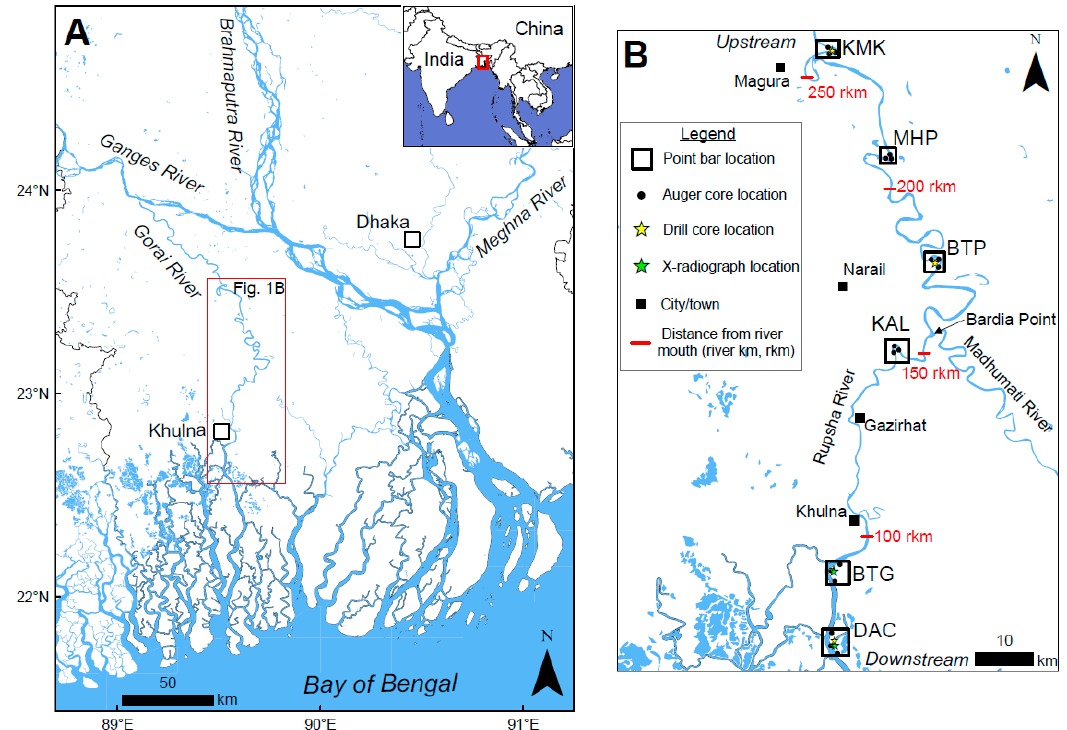
Figure 1. ( A ) Geographic context of the study area within greater Bangladesh and Southeast Asia. The Gorai River is influenced by fluvial forces (e.g., monsoonal flood discharge) from the Ganges and marine forces (e.g., meso-scale tides) from the Bay of Bengal. ( B ) Map of the main stem of the Gorai River illustrating sampling locations codified by the names of nearby villages: Dacope (DAC), Batiaghata (BTG), Kalia (KAL), Bhatiapara (BTP), Mohammadpur (MHP), and Kamarkhali (KMK). Note that between Bardia Point and Khulna, the Gorai is locally referred to as the Rupsha River. Downstream of Khulna the Gorai is locally known as the Pussur River.